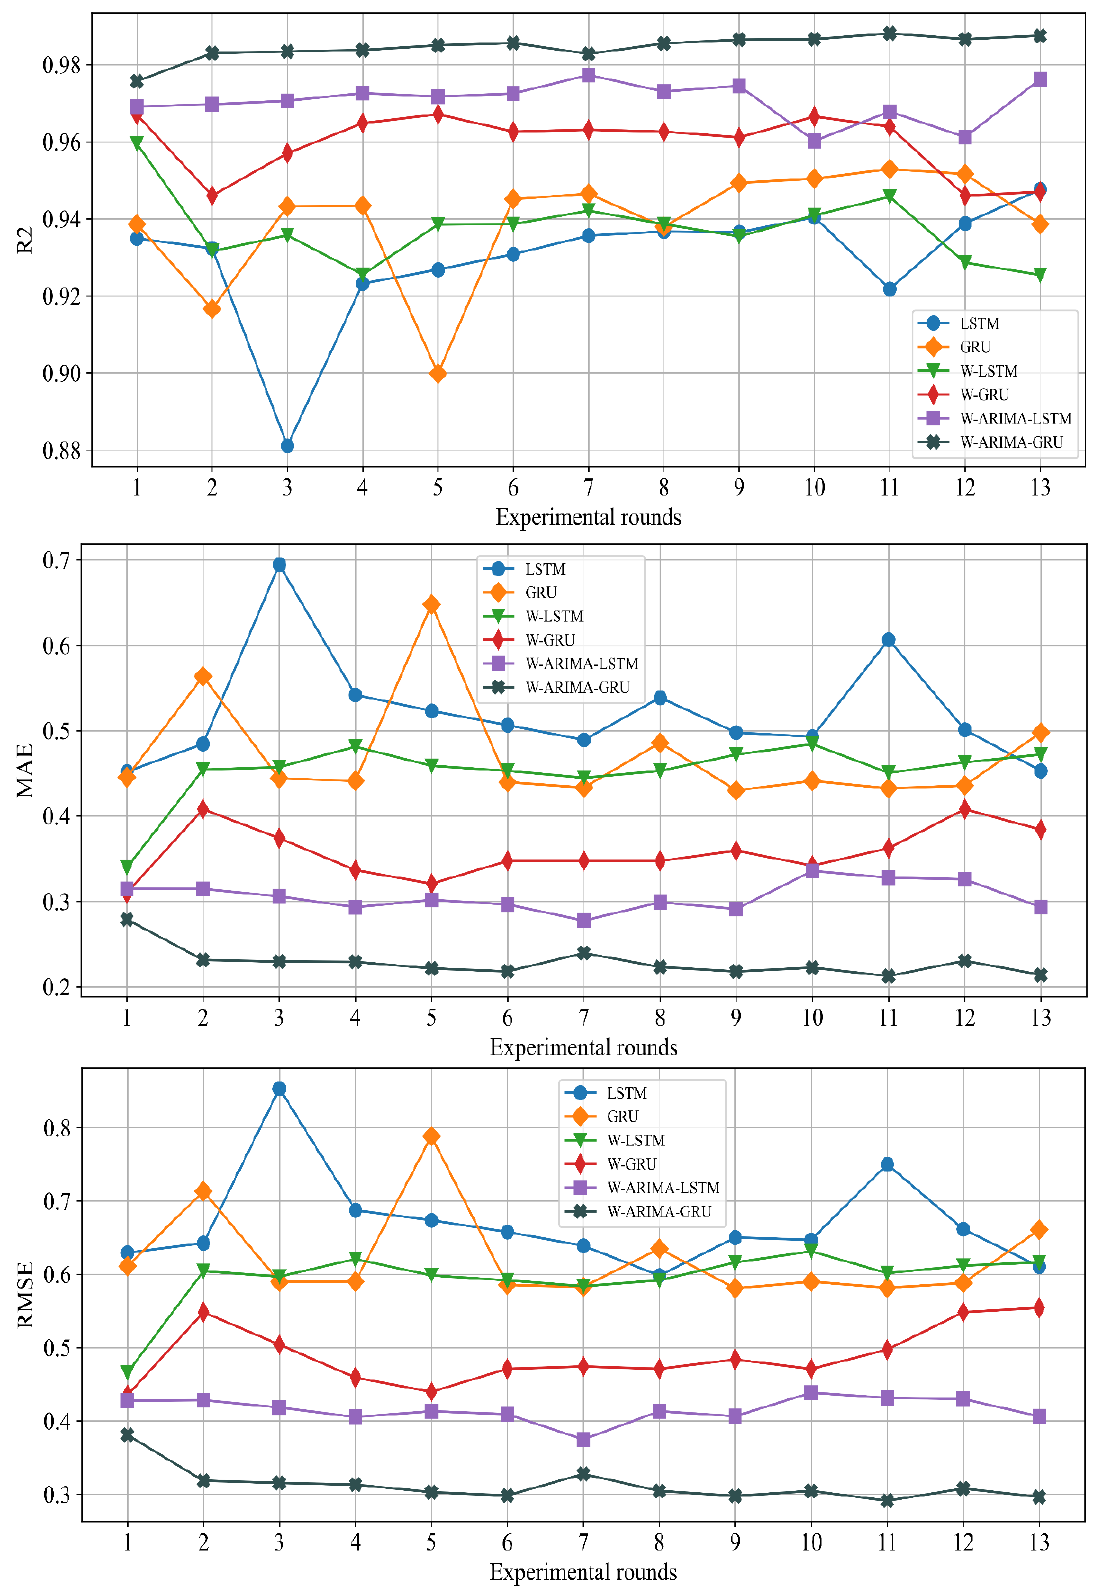
Figure 14. Performance indicators of six prediction models.